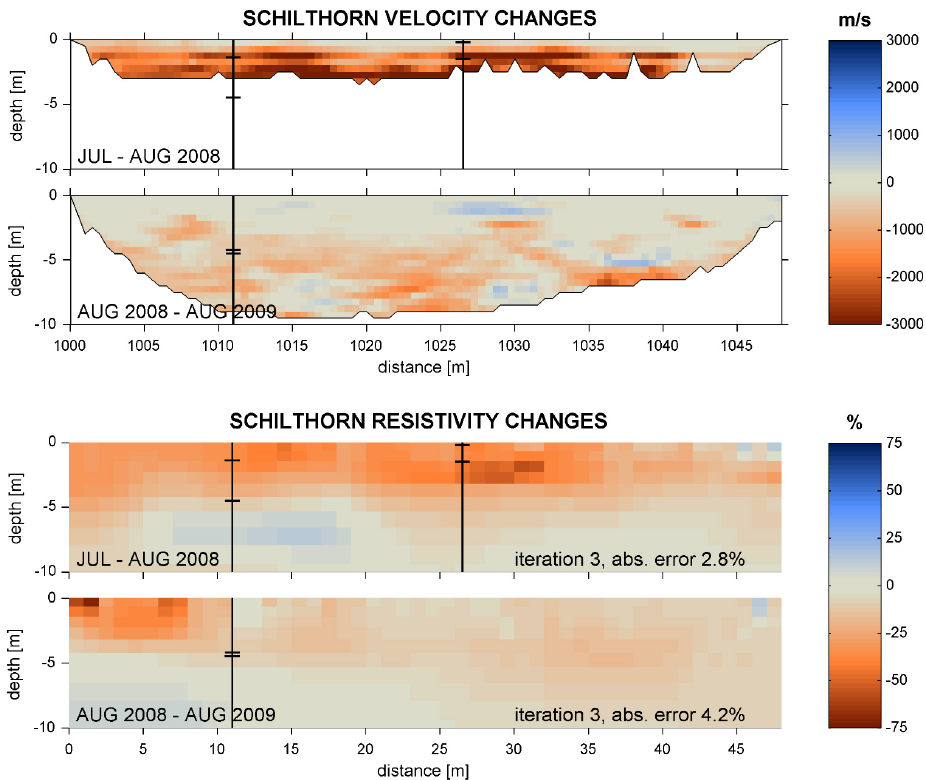
Fig. 11. Comparison of temporal change in seismic velocities with changes in electric resistivities for July to August 2008, and August 2008 to August 2009 at Schilthorn. Locations of the boreholes and the respective thaw depth for both dates are